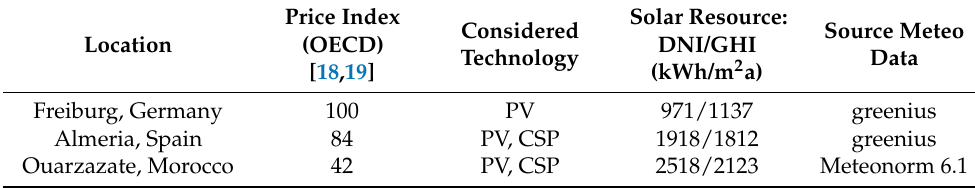
Table 1. Summary locations of the